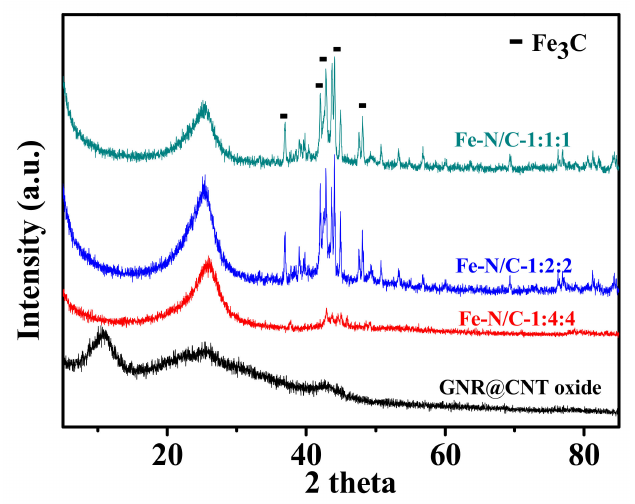
Figure 3. XRD patterns of Fe-N/GNR@CNT samples changing with the FeCl 3 doping